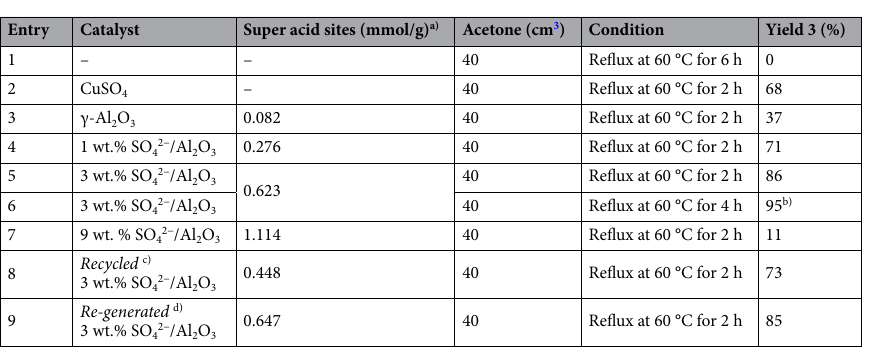
Table 3. Acetalization of ribonolactone with acetone.